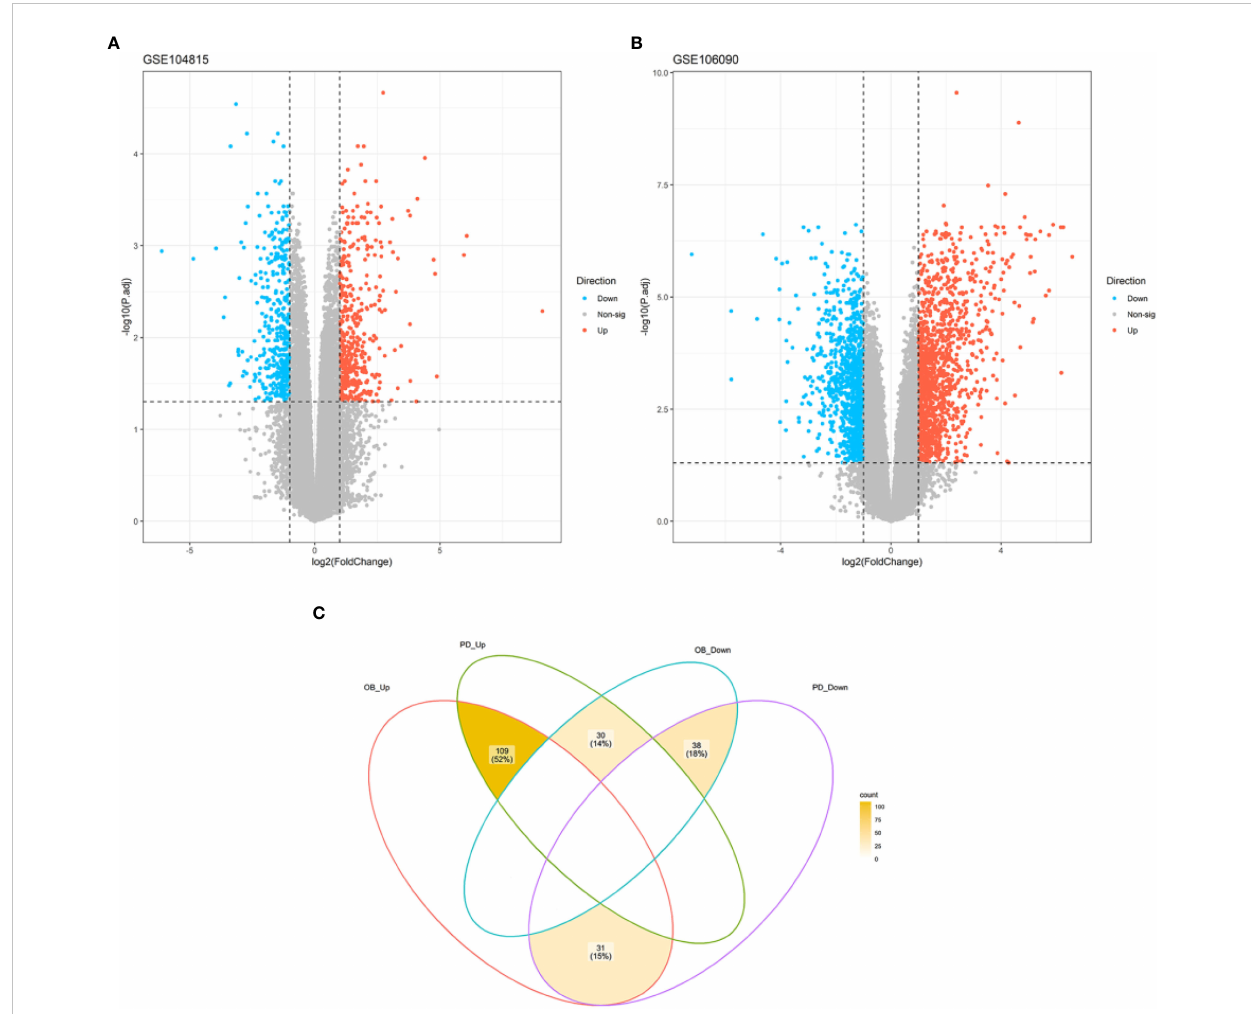
FIGURE 1 Volcano plot of DEGs and Venn diagram of common DEGs. (A) A total of 667 DEGs were identi fi ed between OB and healthy controls. (B) A total of 2191 DEGs were identi fi ed between PD and healthy controls. (C) A total of 109 common up-regulated genes and 38 common down-regulated genes were identi fi ed in OB and PD. DEGs, differentially expressed genes; OB, Obesity; PD,